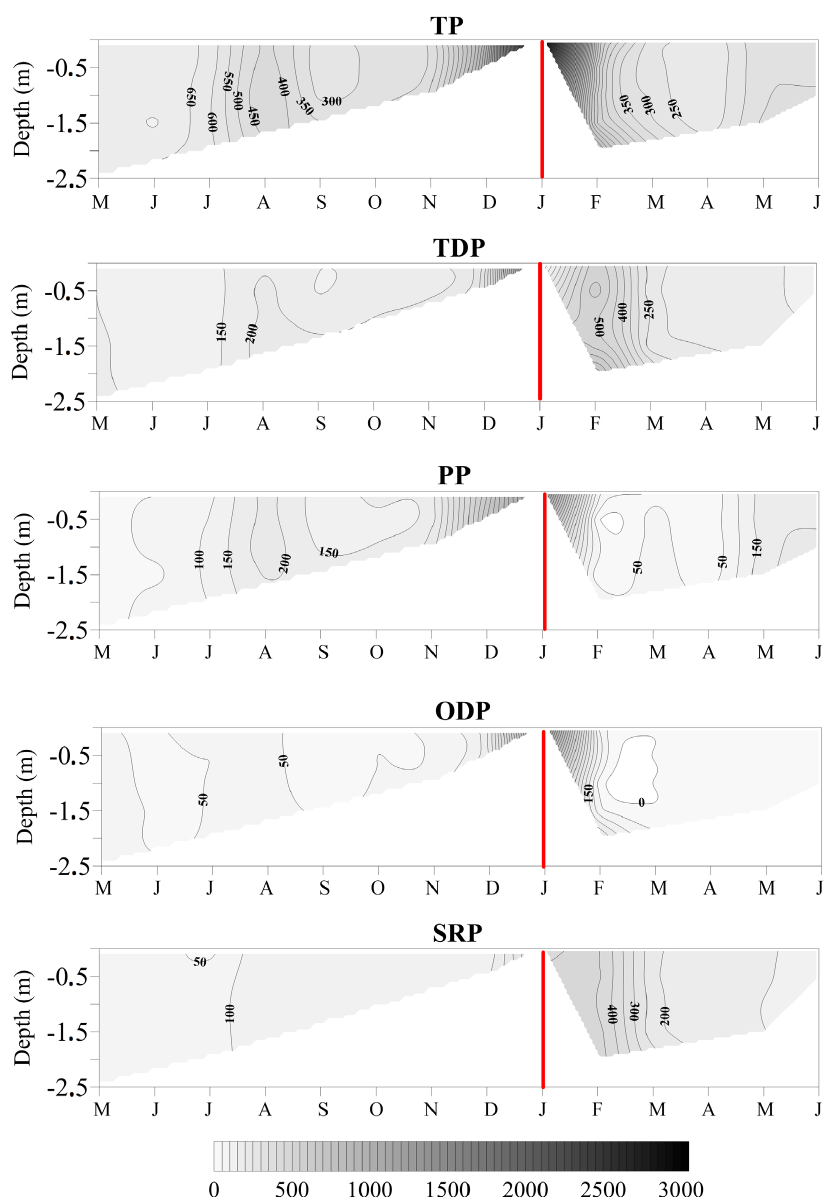
Figure 6. Total Phosphorus (TP), Total Dissolved Phosphorus (TDP), Particulate Phosphorus (PP), Organic Dissolved Phosphorus (ODP) and Soluble Reactive Phosphorus (SRP) in Cruzeta from May 2015 to June 2016. The red line is indicating the highest rainfall in the period, which contributed to the increase in water depth, as can be seen in the Table 1. Mean, maximum and minimum values of the phosphorus forms analysed in the water of the Gargalheiras and Cruzeta reservoirs from May 2015 to June 2016.